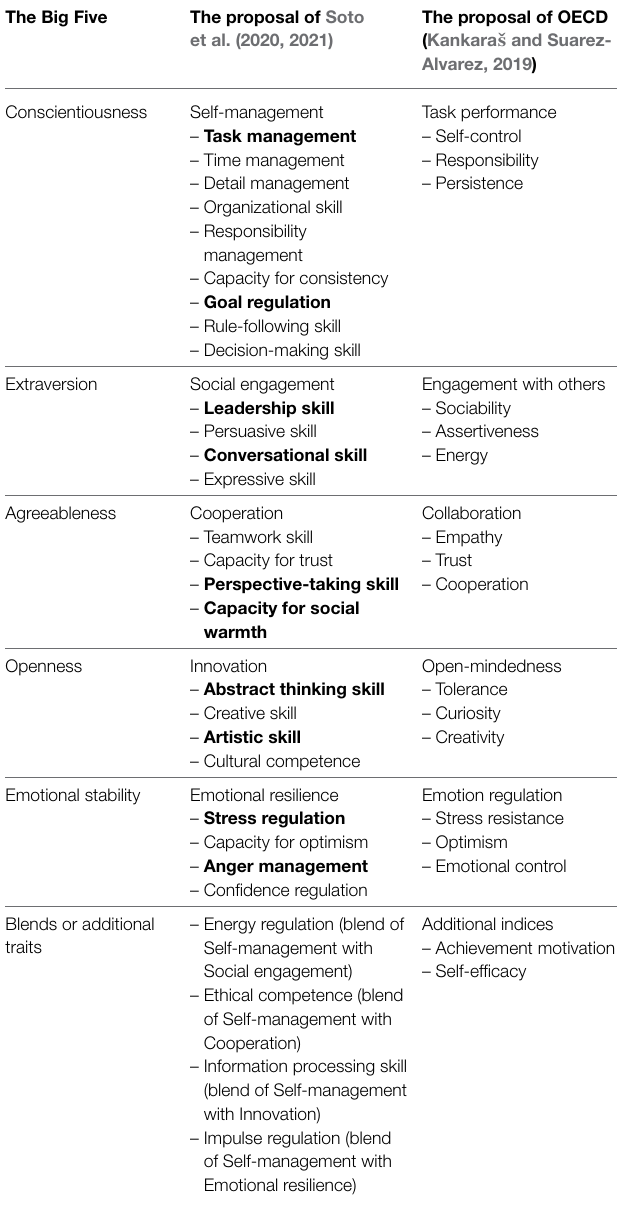
TABLE 2 | Specific social and emotional skills located within Big Five domains in two